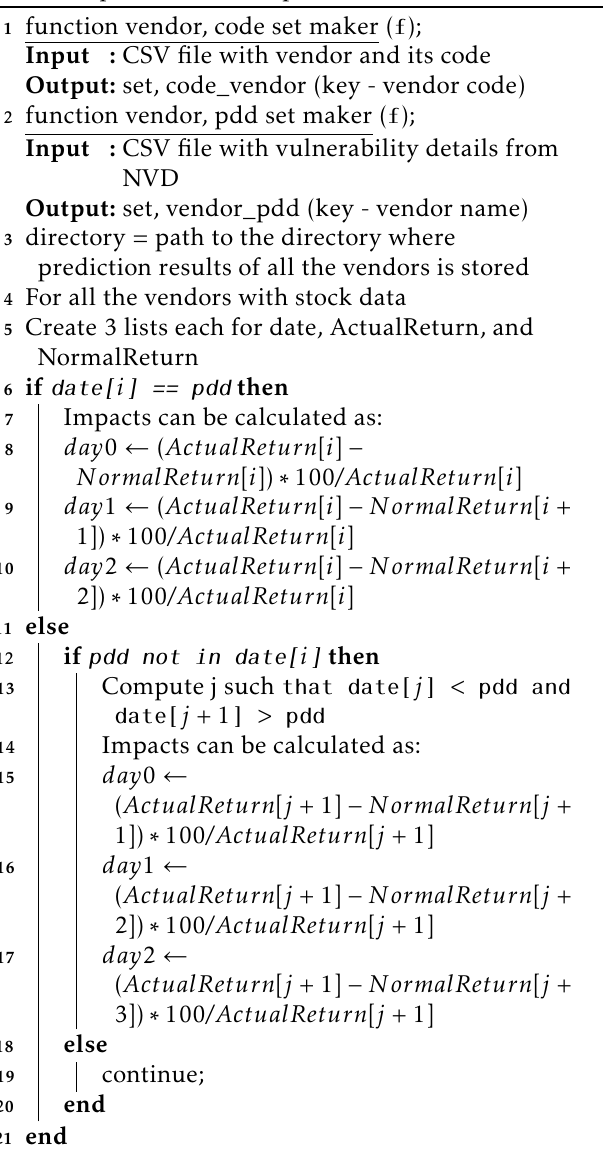
Algorithm 2: Impact calculation from prediction results. pdd here means public disclosure